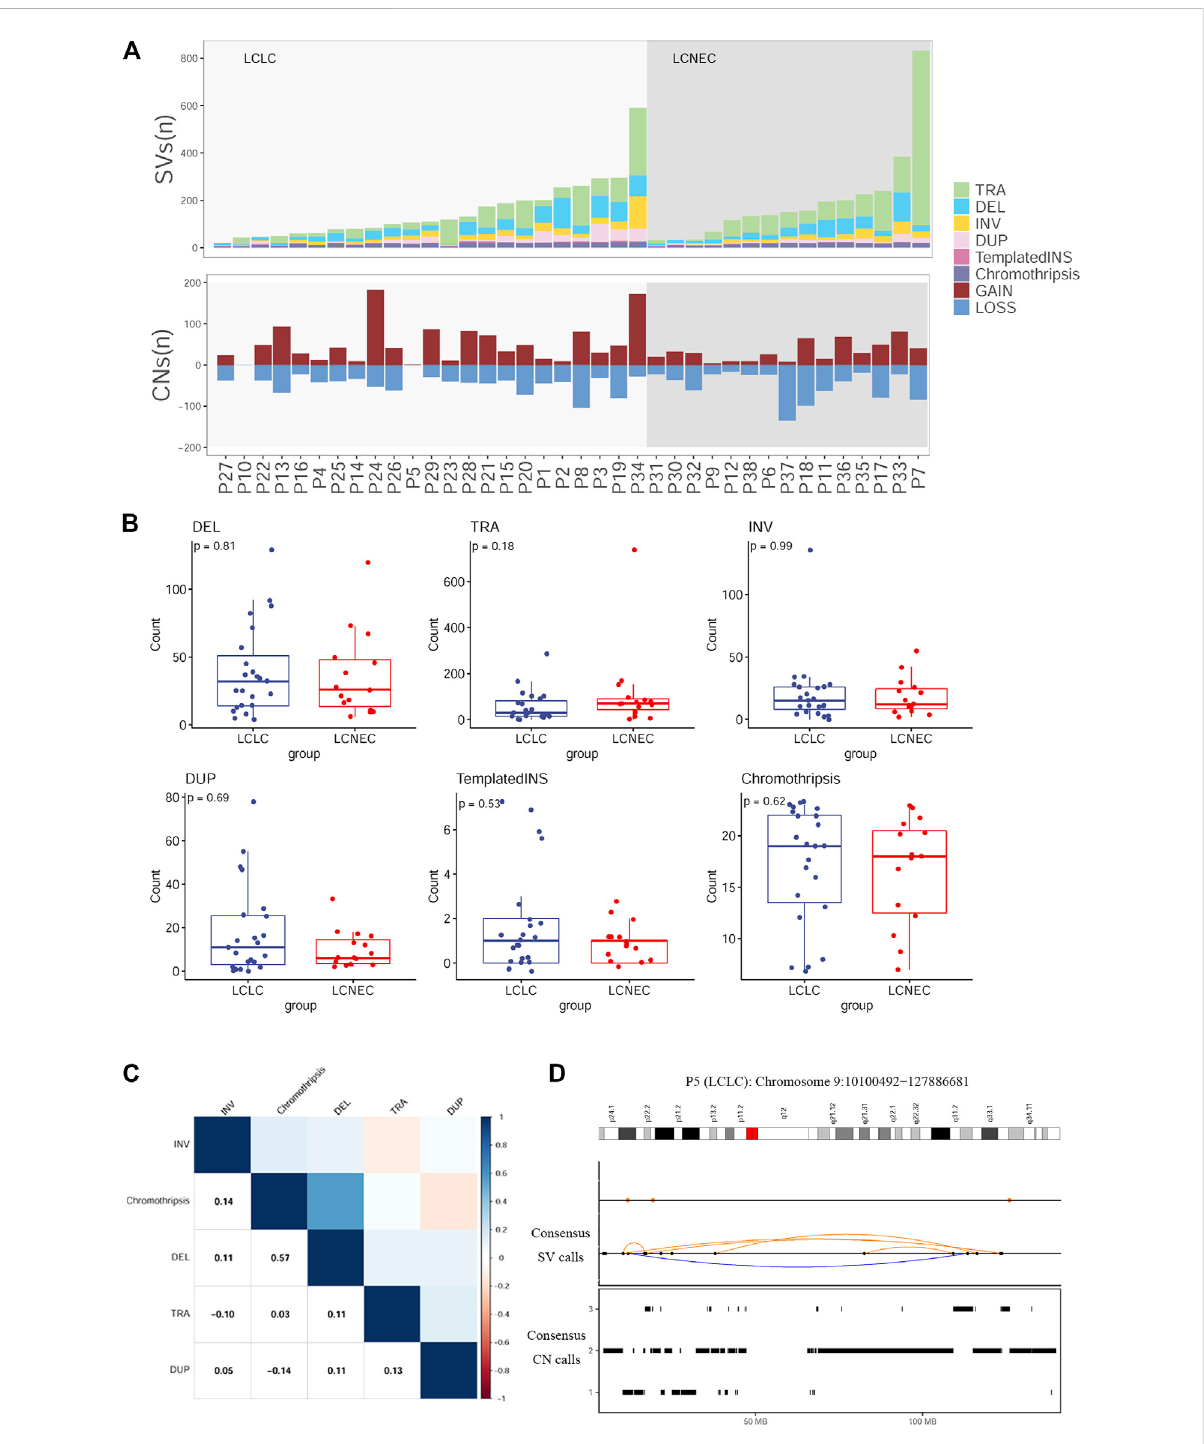
FIGURE 4 Distribution of SVs in LCLC and LCNEC (A) Stacked bars show the genome-wide burden of each SV class (color) in each patient (x-axis). Lower panel: SVs resulting in copy-number gain or loss (B) Comparison of each SV burden between LCLC and LCNEC. (C) Pairwise associations between the numbers of SVs across patients. Color was determined by the magnitude of positive (blue) and negative (red) Spearman correlation coef fi cients, plotted only where q < 0.1. (D) Example of a chromothripsis event in chromosome 9 involving CN oscillations with interspersed loss of heterozygosity and templated insertions. Breakpoints corresponding to interchromosomal SVs are depicted as colored dots in the SV pro fi le, whereas intrachromosomal SVs are represented with black dots and colored